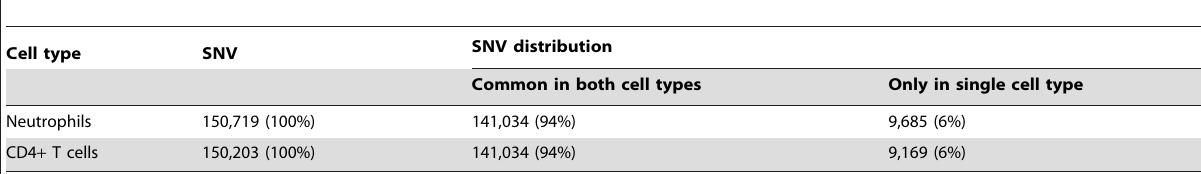
Table 2. SNVs detected in neutrophils and CD4 + T cells.